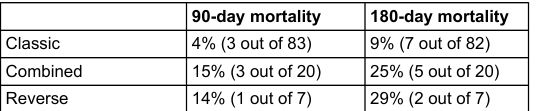
Table 3: Mortality rates after surgery.